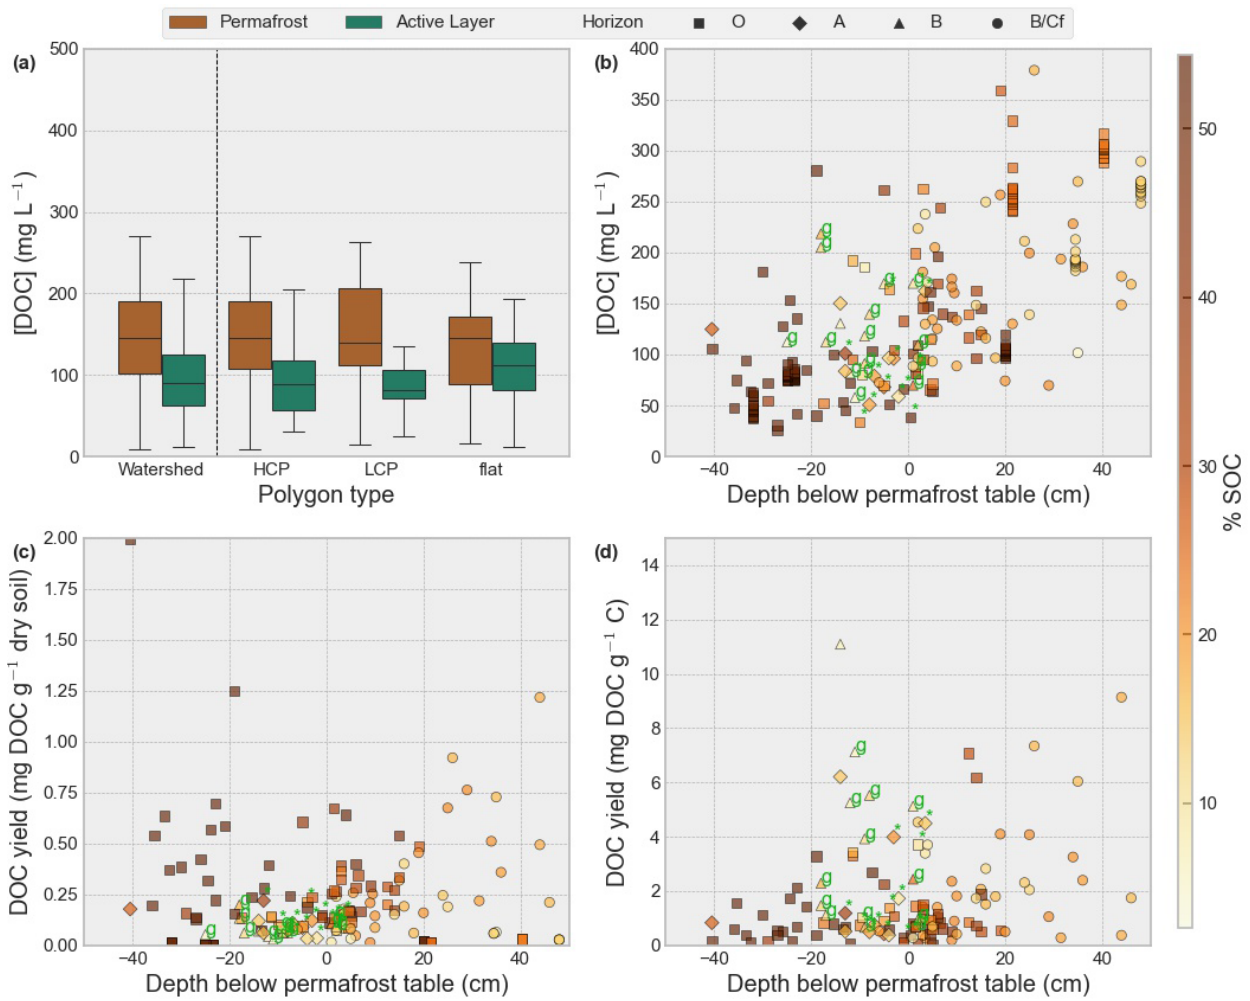
Figure 4. Porewater DOC concentrations (mgL − 1 ) across the entire watershed and identified polygon types (HCP, LCP and flat) for per- mafrost (dark-grey boxplots) and the active layer (light grey) (a) vs. depth (b) , yield of DOC (in mg) per gram dry soil (c) and yield of DOC (in mg) per gram soil OC (d) . Color indicates soil organic carbon content (%). Marker type distinguishes soil horizon. Cryoturbated soil samples are annotated with “*”, and samples of gleyed soil are annotated with